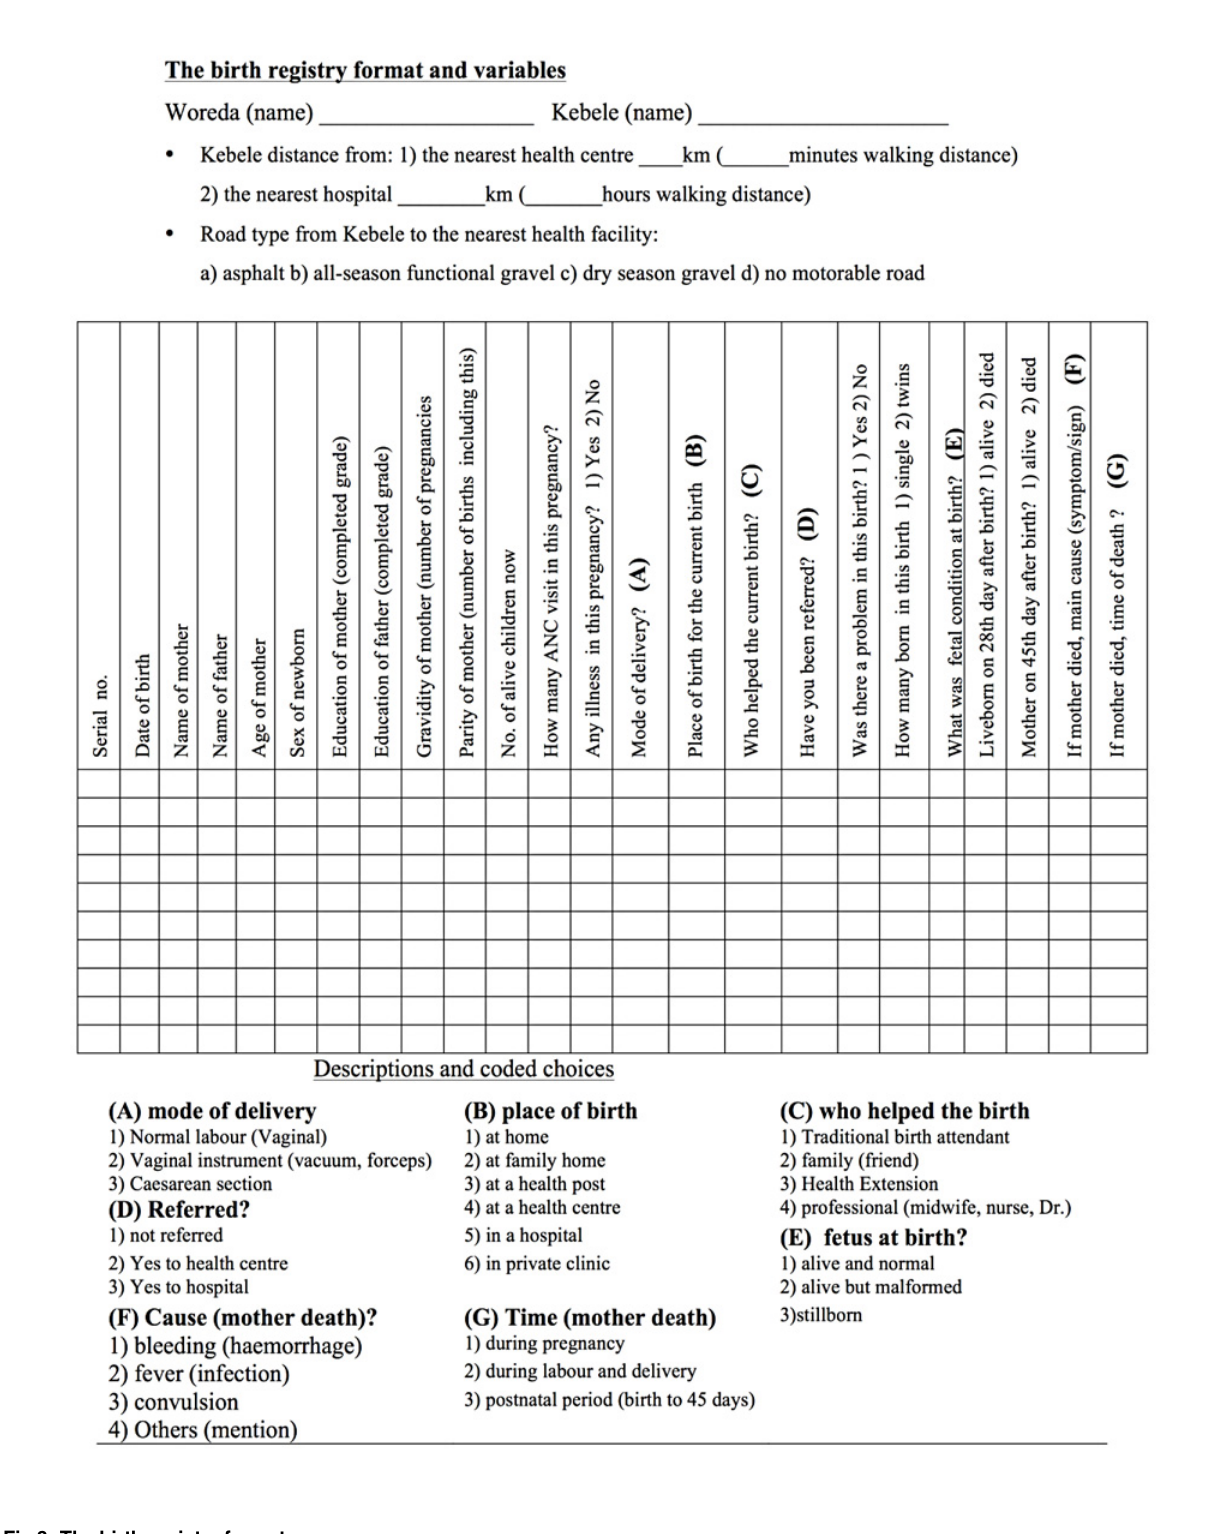
PLOS ONE | DOI:10.1371/journal.pone.0119321 March 23,